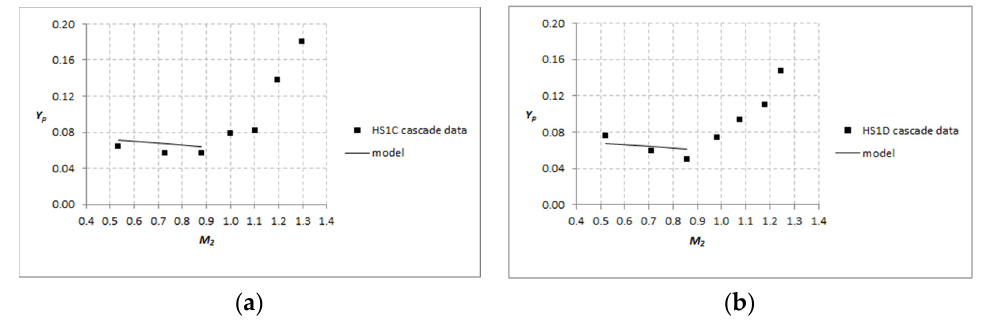
Figure 4. Comparison of simulated and experimental total pressure profile loss coefficient for ( a ) HS1C cascade [24]; ( b ) HS1D cascade [24].